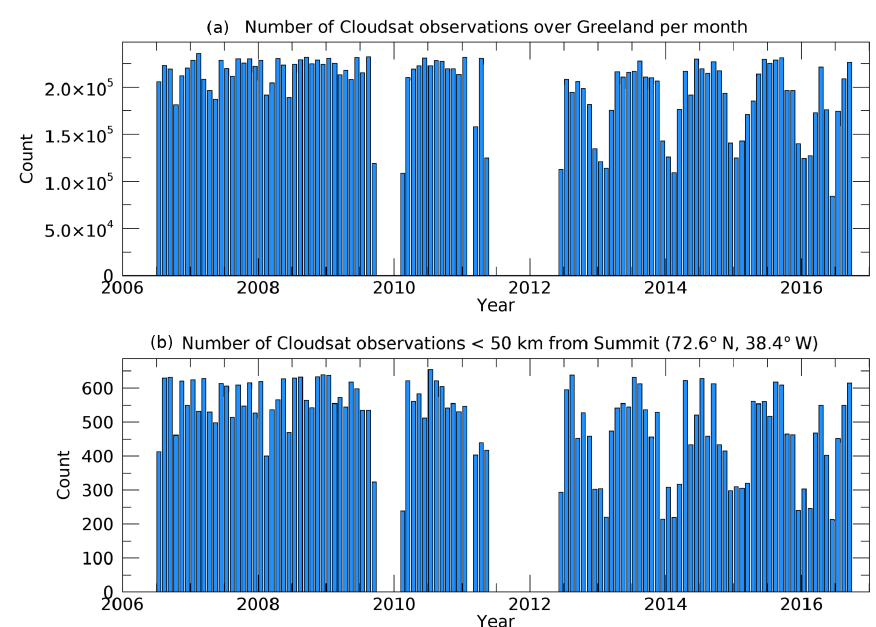
Figure 1. Number of CloudSat observations per month all over Greenland (a) and within 50km of Summit Station (b) .